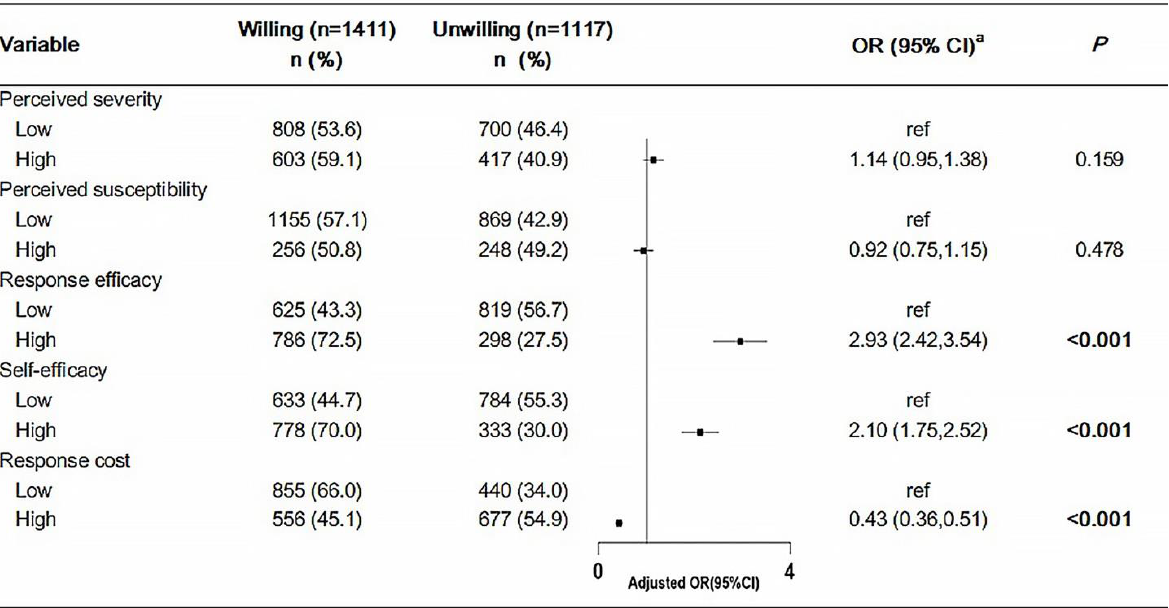
Figure 1. Multiple logistic regression for psychosocial factors predicting the willingness to receive the COVID-19 vaccine. ( a OR was adjusted for age, sex, occupation, region, self-rated overall health, the number of chronic diseases, and all the psychosocial factors).